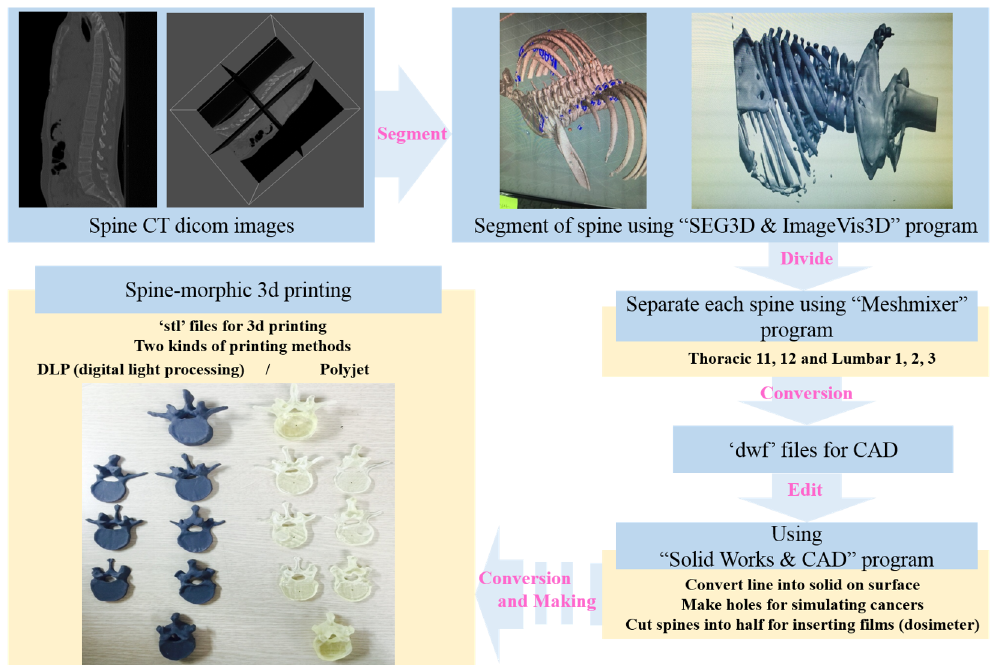
Fig 1. Diagram of the workflow framework that we followed for producing 3D printed spine-shaped phantom from CT data.